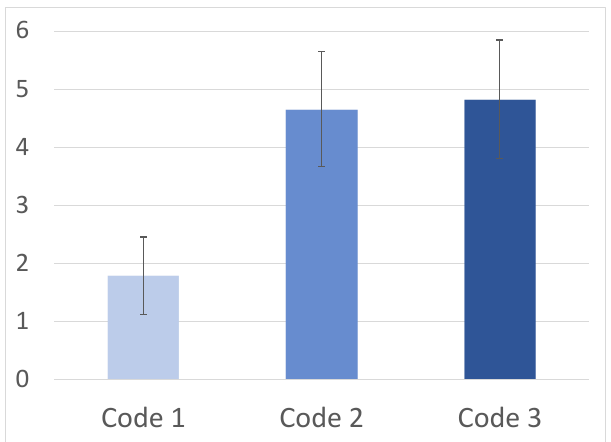
Figure 7. Mental effort felt by the participants and written on the NASA-TLX for the three different Code